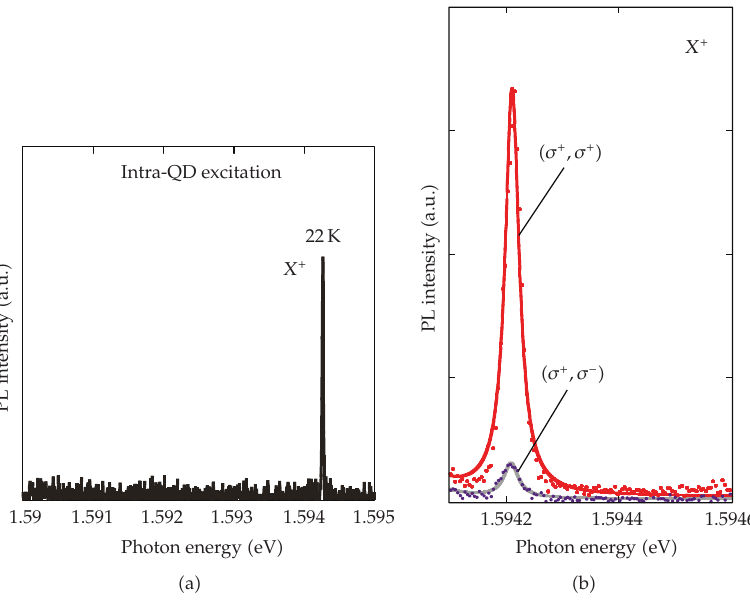
Figure 6: (cid:5) a (cid:6) X (cid:9) line selective population by intra-dot excitation. FSS is not observed since the two X (cid:9) states with their total spin of ± 1 / 2 are degenerated. (cid:5) b (cid:6) Detection polarization-selective PL spectra of the X (cid:9) line measured under the σ (cid:9) excitation. Red curve is a result of co-circular (cid:5) σ (cid:9) (cid:6) detection, while the blue curve is a result of cross-circular (cid:5) σ − (cid:6) detection. The degree of circular polarization defined by (cid:5) I σ (cid:9) − I σ − (cid:6) / (cid:5) I σ (cid:9) (cid:9) I σ − (cid:6) is as high as 0.85 without external magnetic